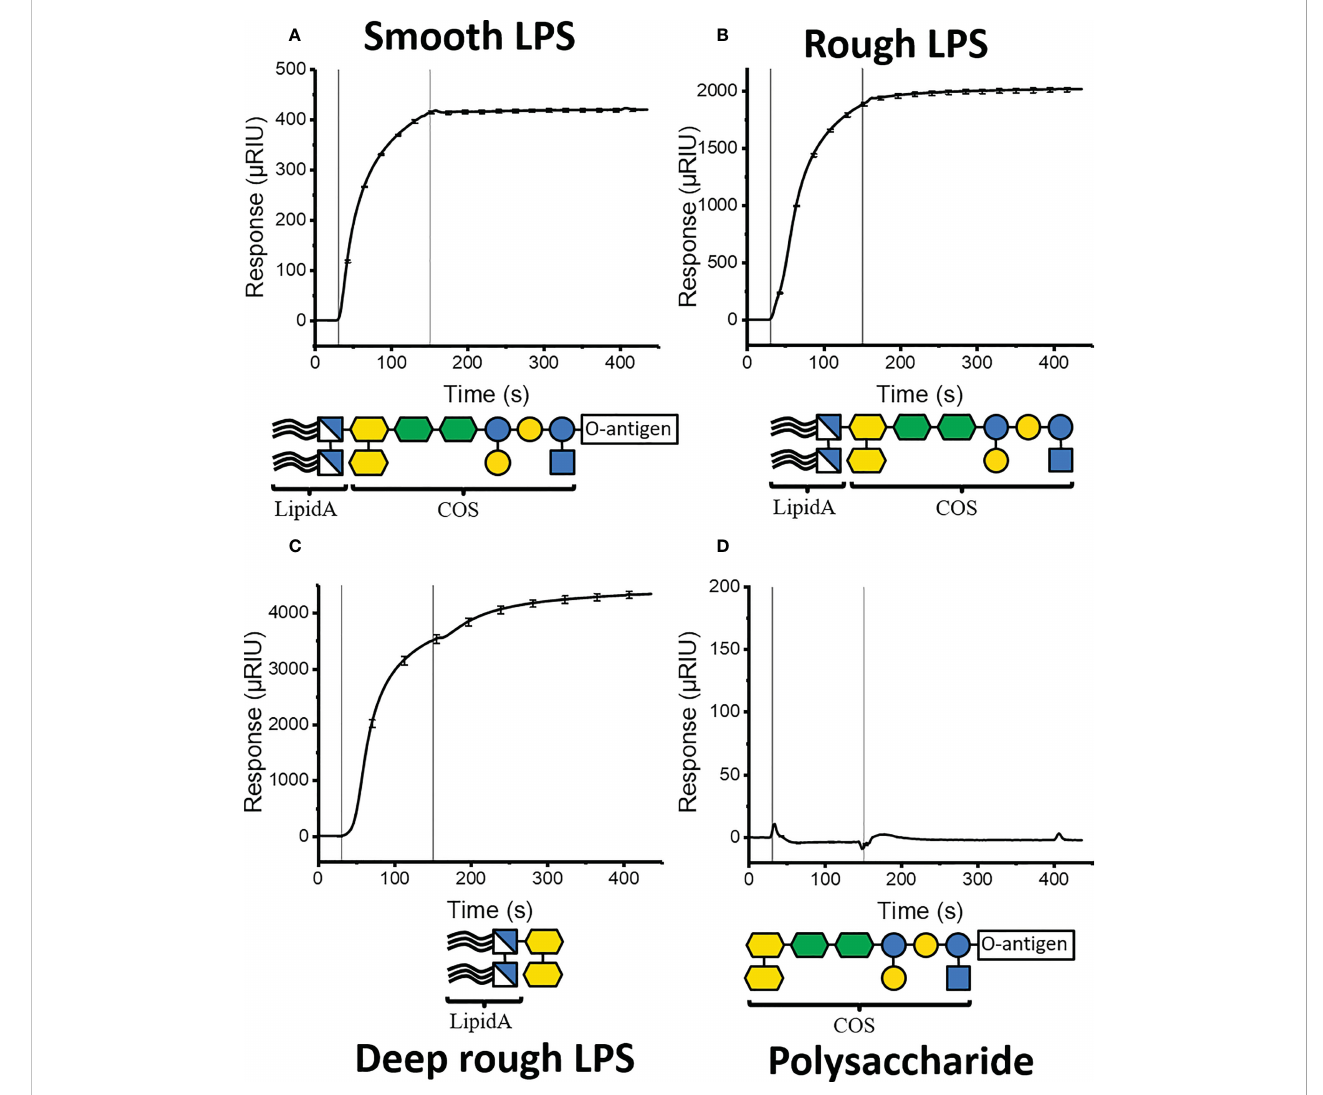
FIGURE 3 SPR binding isotherms following injection of different S. typhimurium LPS components to immobilized K9-GCN4. Vertical lines indicate the start and end of injection. (A) injection of whole LPS (B) Injection of rough LPS, lacking O-antigen. (C) Injection of deep rough LPS, lacking all sugars except the two proximal KDOs. (D) Injection of LPS polysaccharide lacking lipid